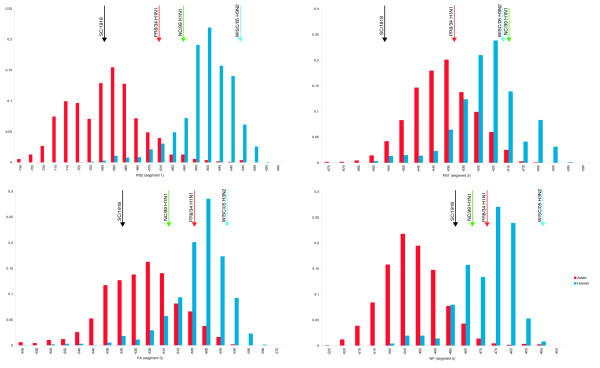
Folding free energy distributions for human and avian influenza A polymerase gene segments (in kcal/mol). The black arrows indicate the folding energies for the corresponding 1918 virus segment. Red, A/Puerto Rico/8/1934 (H1N1) (PR8/34); green, A/New Caledonia/20/1999 (H1N1) (NC/99); blue, A/Wisconsin/67/2005 (H3N2) (Wisc/05). The x-axis is the folding energy calculated by the program RNAfold [35], and the y-axis is the relative frequency of this folding energy in the viral population.